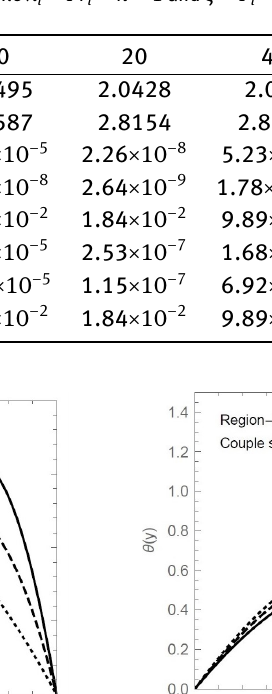
Table 1: Averaged squared residual errors E u 1 m ( y ), E u 2 m ( y ), E θ 1 m ( y ), E θ 2 m ( y ), E ϕ m ( y ) and E t m ( y ) using optimal values (cid:126) u